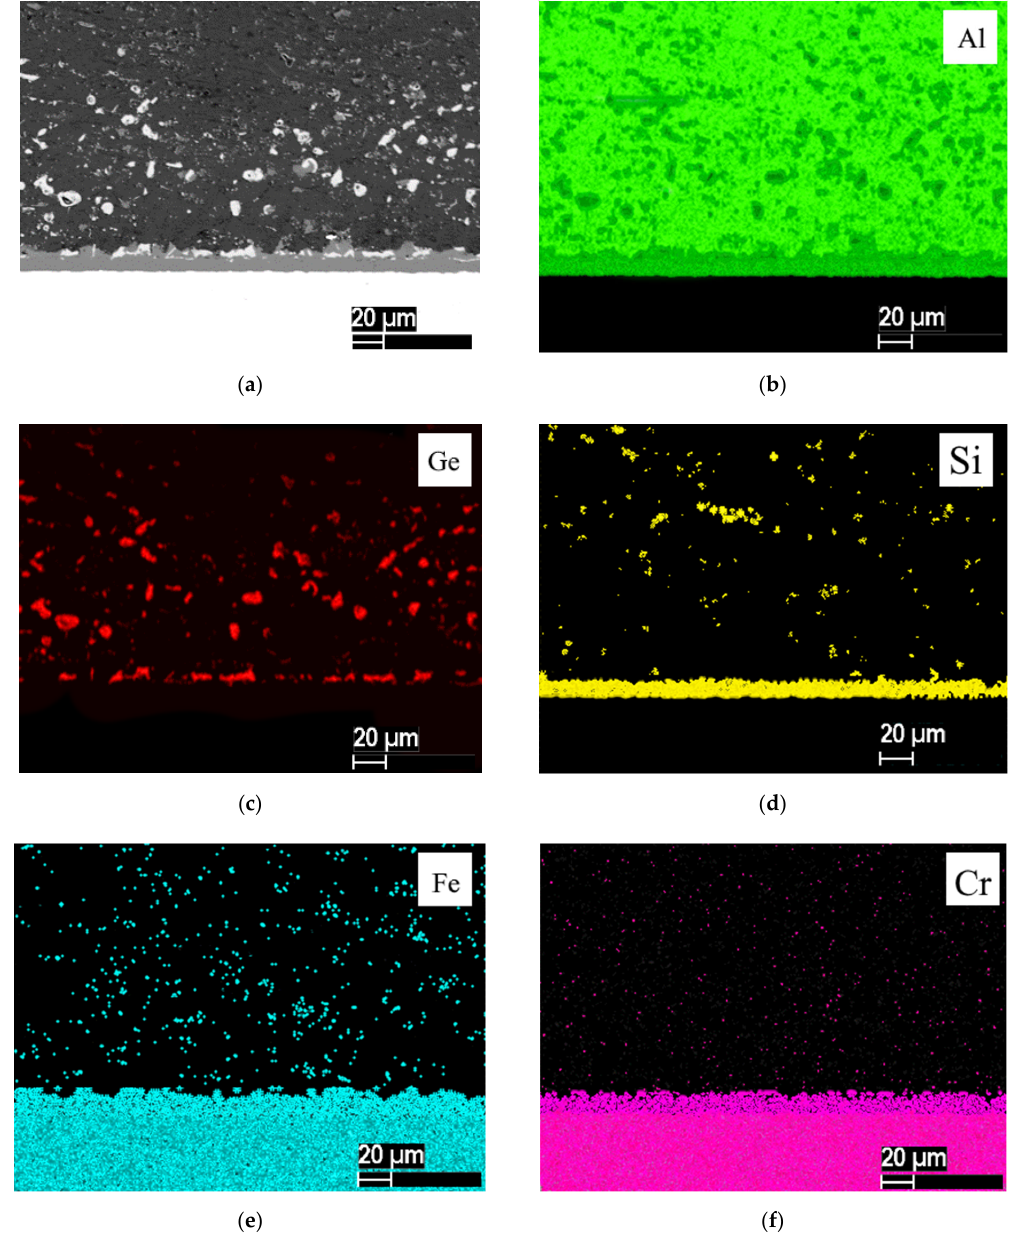
Figure 13. BSD image of the AISI 304/AA 6082 joint brazed according to the 540 °C/30 min mode at 1000× magnification: ( a ) initial image; ( b ) distribution of Al; ( c ) distribution of Ge; ( d ) distribution of Si; ( e ) distribution of Fe; ( f ) distribution of Cr. Chemical distribution maps indicate that germanium does not participate in the for ‐ mation of the brazed joint seam, and therefore, it was concluded that the presence of ger ‐ manium in filler alloys affects only the critical temperatures of phase transformation (Fig ‐ ure 13c).